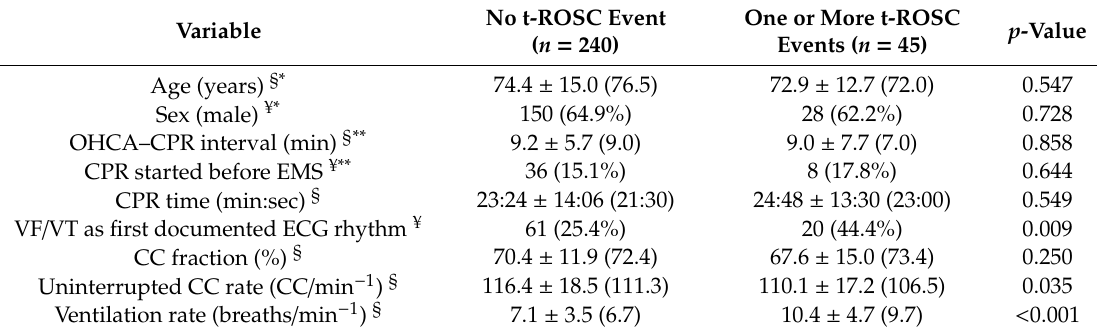
Table 3. Relationships of CA-related variables with t-ROSC